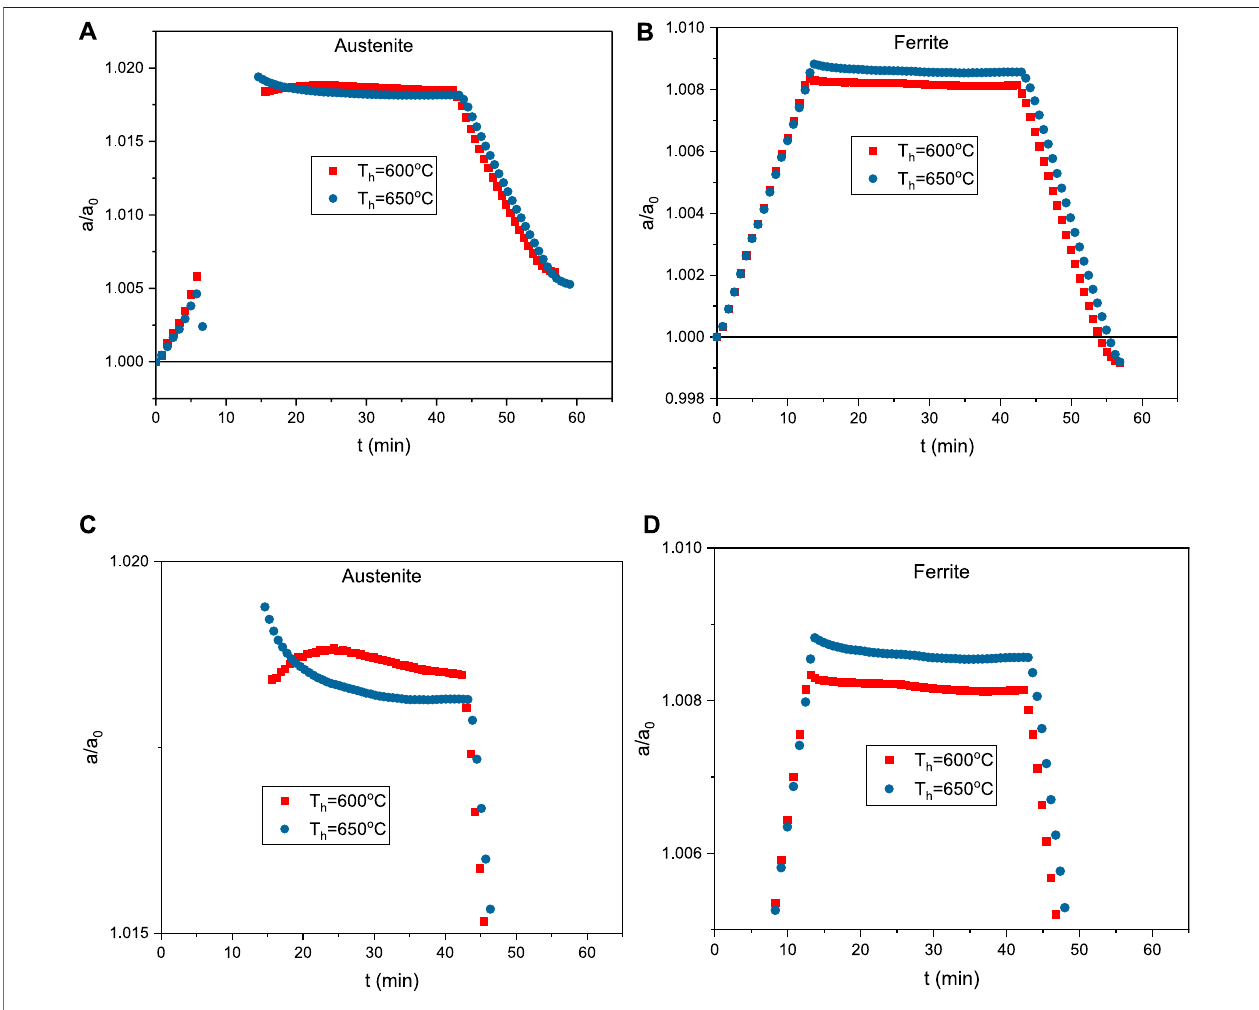
FIGURE 7 | Normalized lattice parameters as a function of time during ICA thermal cycles for peak hold times of 600 and 650 ° C: (A) austenite and (B) ferrite/ martensite. (C) and (D) are rescaled versions of (A) and (B) to show a clearer trend of lattice constant change during holding.